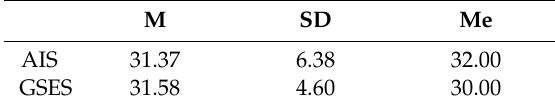
Table 6. Acceptance of Illness Scale (AIS) and Generalized Self-E ffi cacy Scale (GSES) scores in the hyperglycemic pregnant women